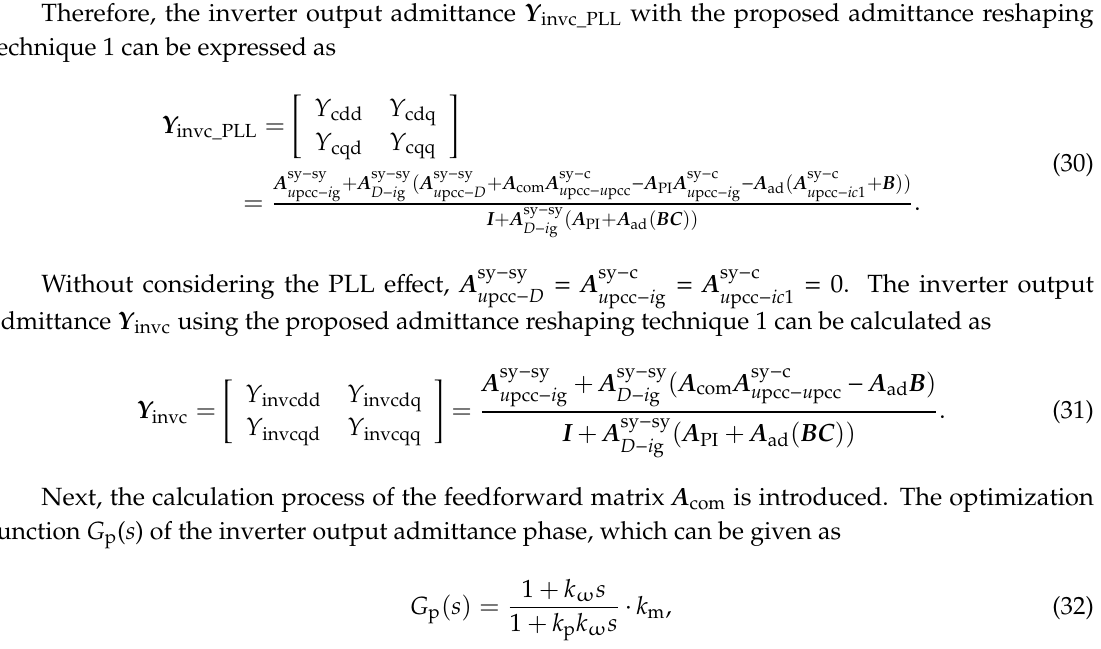
Figure 8. The system diagram of proposed admittance reshaping technique 1 considering the phase-locked loop (PLL) effect.